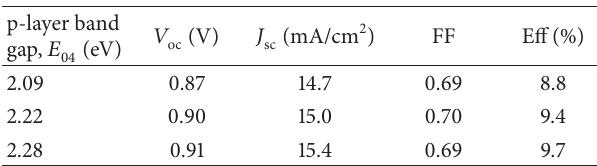
Table 2: Photovoltaic characteristics of a-Si:H solar cells using p- layer with various optical band